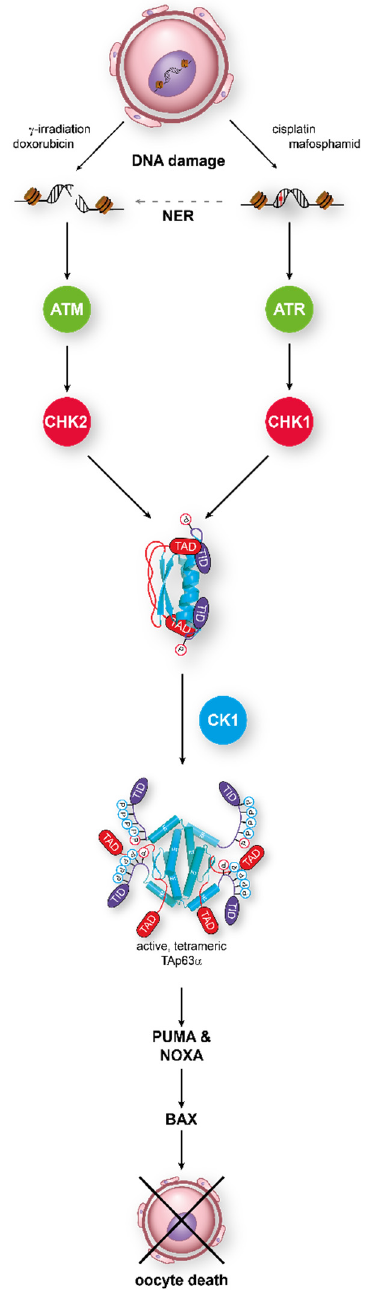
Figure 2. TAp63 α acts as the central integrator for DNA damage signaling in oocytes. Detection of either double-strand breaks or single-strand breaks activates the ATM/CHK2 or the ATR/CHK1 pathway, respectively. Phosphorylation of TAp63 α on S582 by CHK2 or CHK1 recruits a second kinase, CK1, which adds four more phosphates. This leads to opening of the closed dimeric state. In its active tetrameric conformation, TAp63 α acts as a transcriptional activator resulting in the expression of PUMA and NOXA which, in turn, activate Bax.